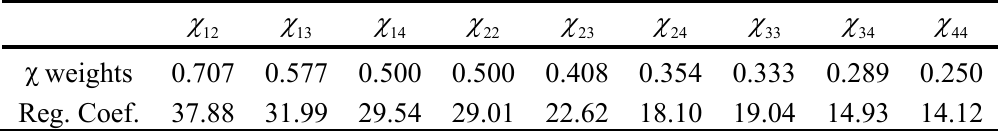
Table 1. χ ’s weights and regression coefficients.